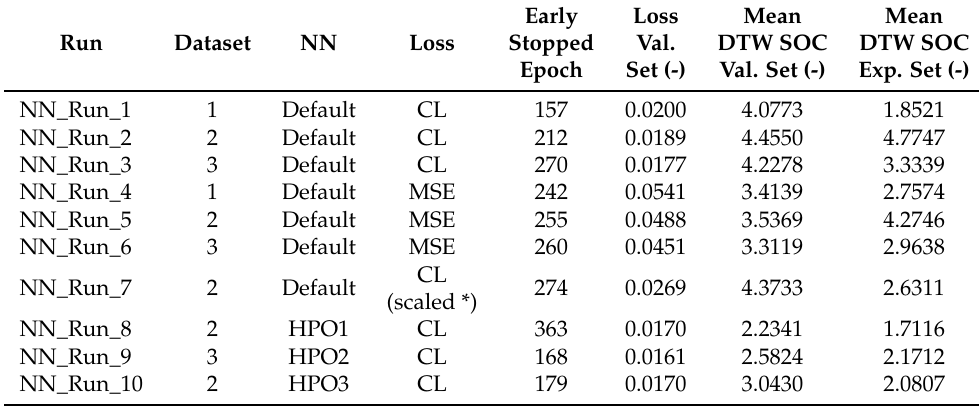
Table A3. Settings and results of the NN-based MPI runs (*—single segments of the custom loss function were scaled with a factor: emod MSE × 1.5, bulk MSE × 1.5, lcid − t MSE × 2, lcid − c MSE ×